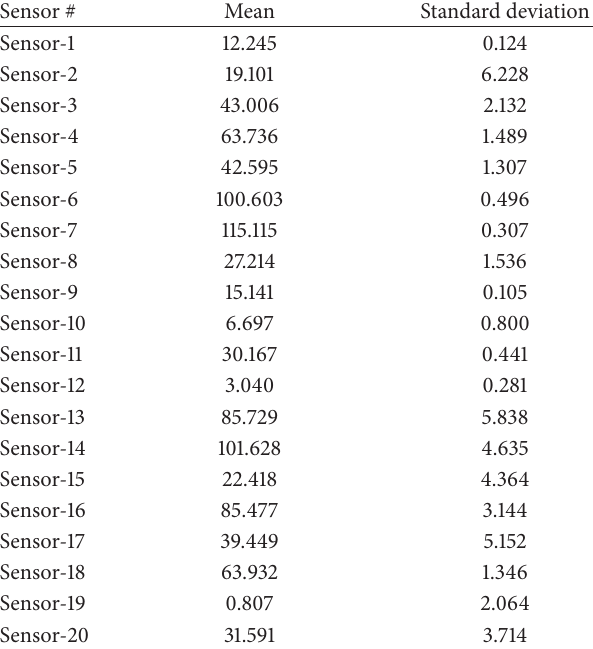
Table 5: Statistical measures of the sensor